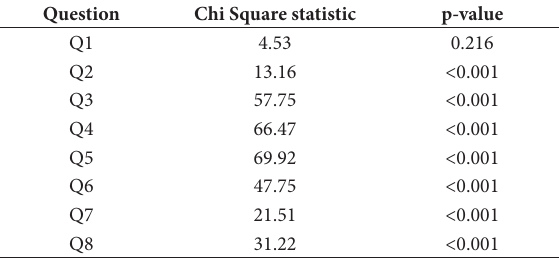
Table 2. Results of Pearson's Chi-squared test with simulated p-value (based on 9999 randomizations) to verify that the an- swers diverged from a stochastic distribution.